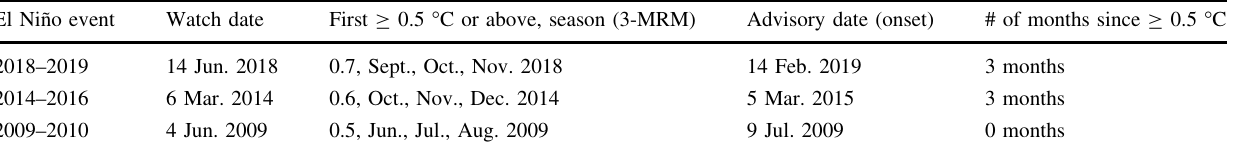
Table 1 Comparison of dates of El Nin˜o Watch, first ONI Index value, El Nin˜o Advisory, and months since first ONI 3-MRM value C 0.5 8 C. Sources : NOAA (2019b, d) El Nin˜o event